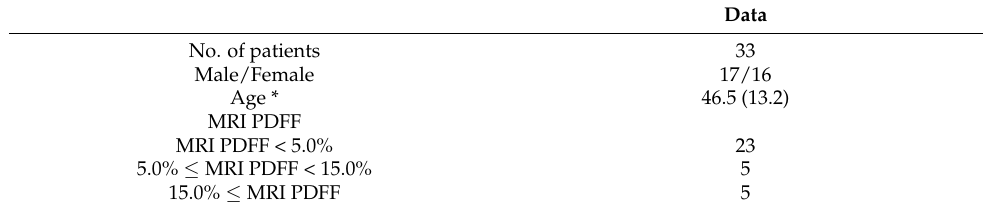
Table 2. The characteristics of the included